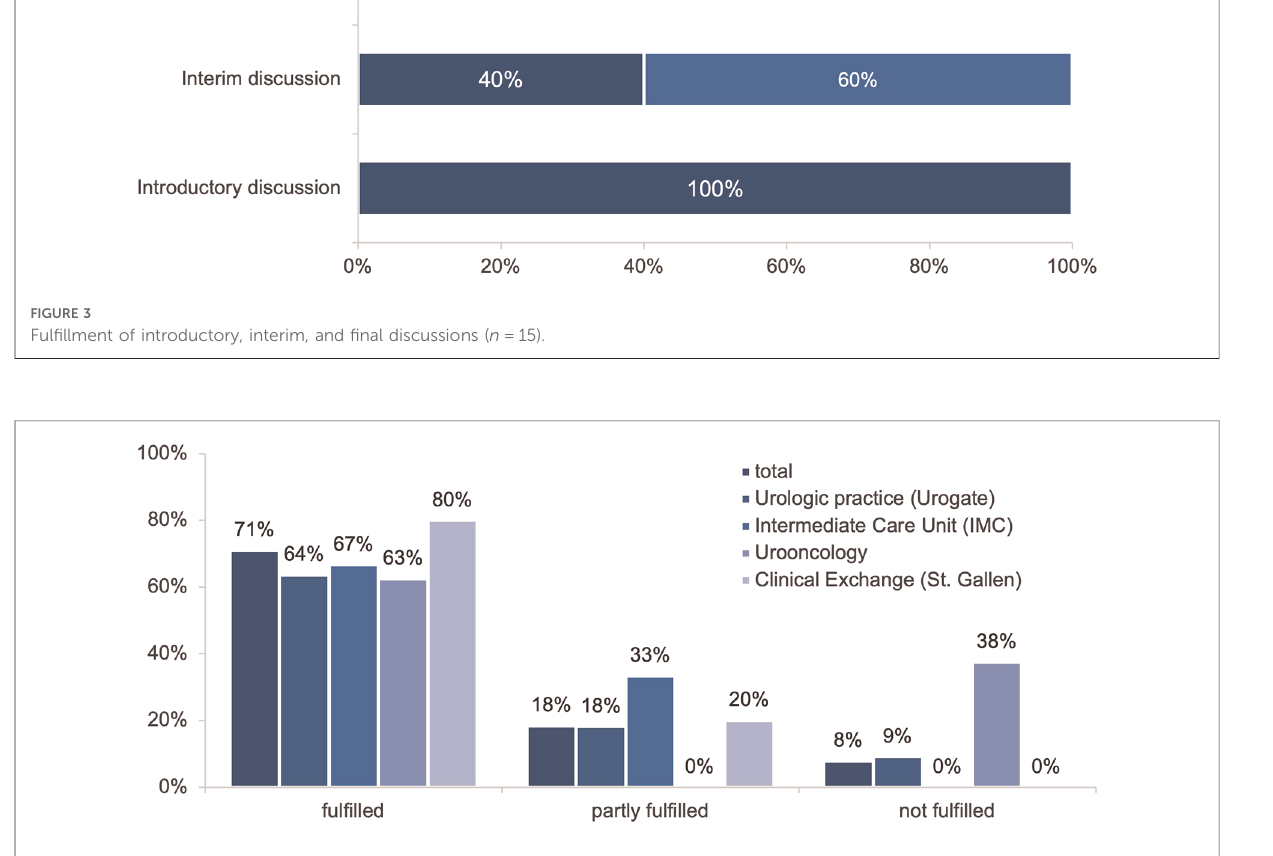
FIGURE 4 Ful fi llment of objectives differentiated by the respective rotation ( n